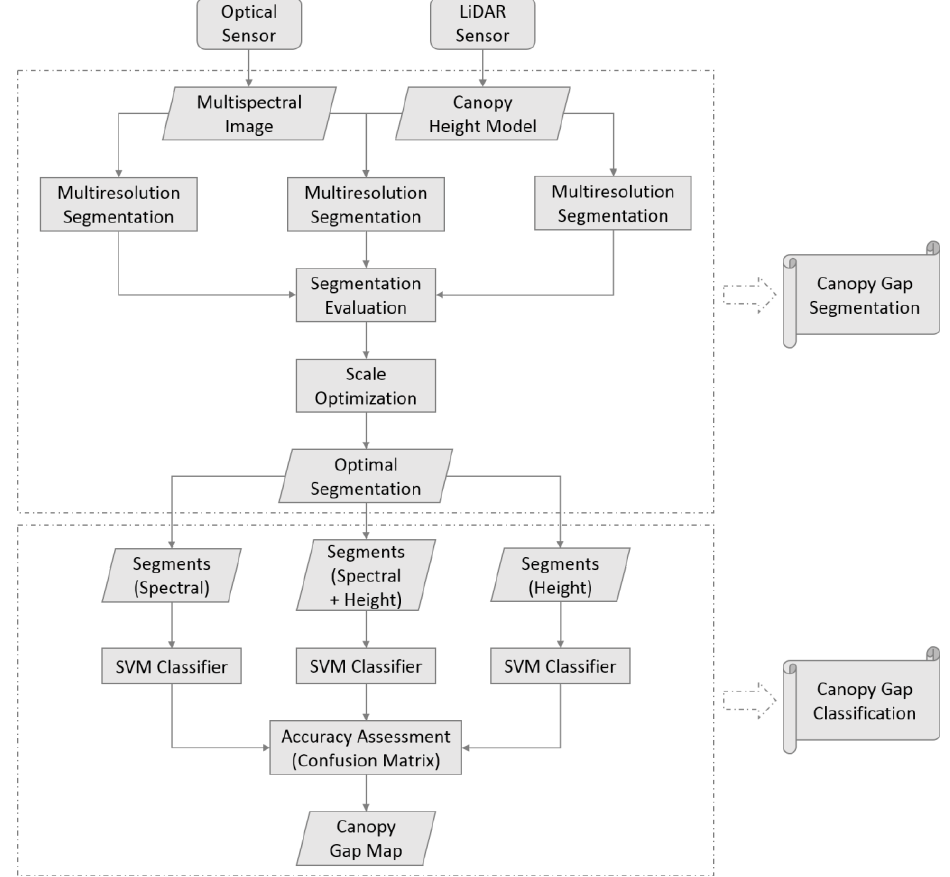
Figure 3. The flowchart of the automated gap delineation and classification using optical and LiDAR data.